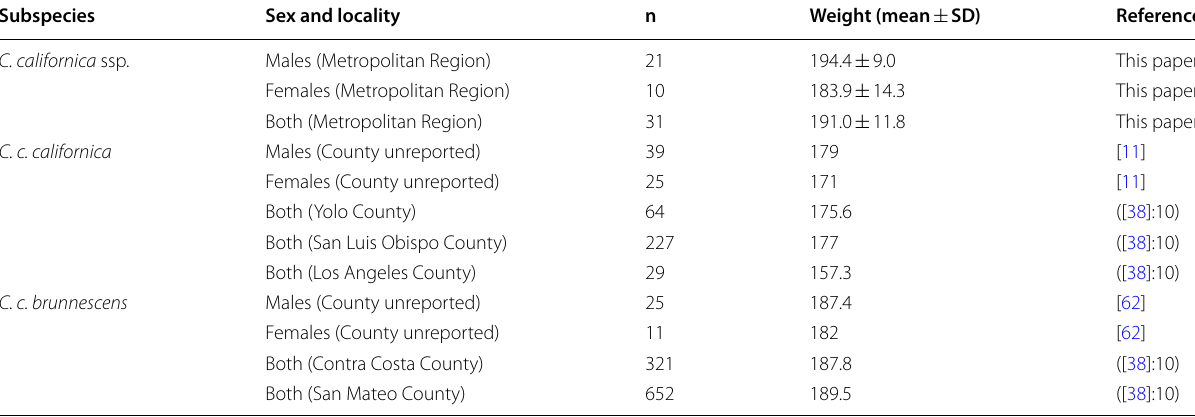
Table 1 Weight (g) of California Quail Callipepla californica according to sex and origin reported here from Metropolitan Region of Chile (unknown subspecies) and from California counties (USA) on C. c. californica and C. c. brunnescens